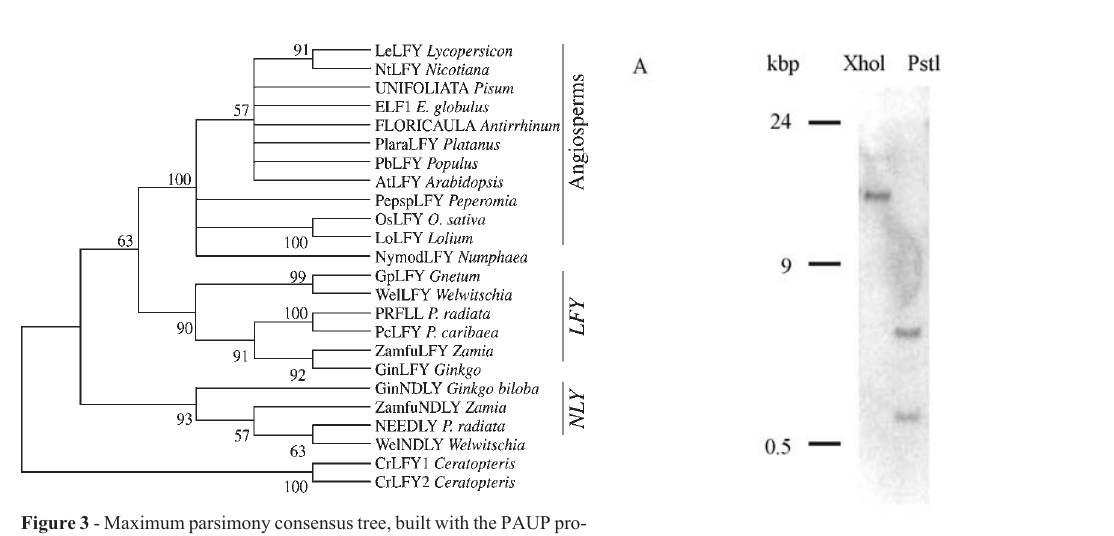
Figure 3 - Maximum parsimony consensus tree, built with the PAUP pro- gram, of deduced amino acid sequences of the complete LFY-like pro- teins.Numbersabovethenodesindicatepercentoftreeswitheachnodein a bootstrap analysis of 1000 random trees. Only the nodes present in 50% or more trees are drawn.